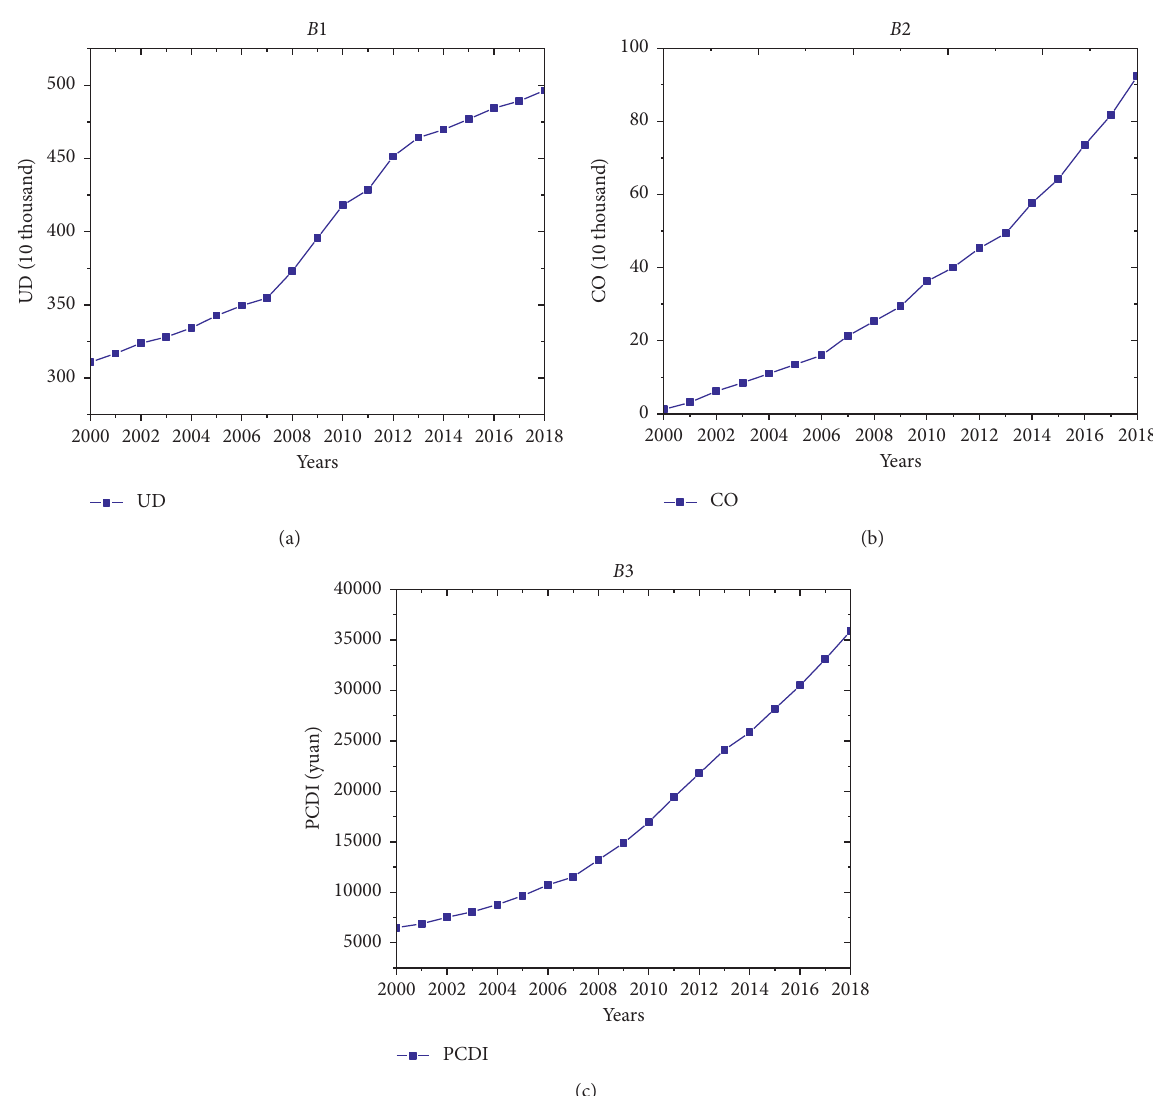
Figure 5: Changes in the three data series for Yancheng from 2000 to 2018: (a) changes in the UD historical data, (b) changes in the CO historical data, and (c) changes in the PCDI historical